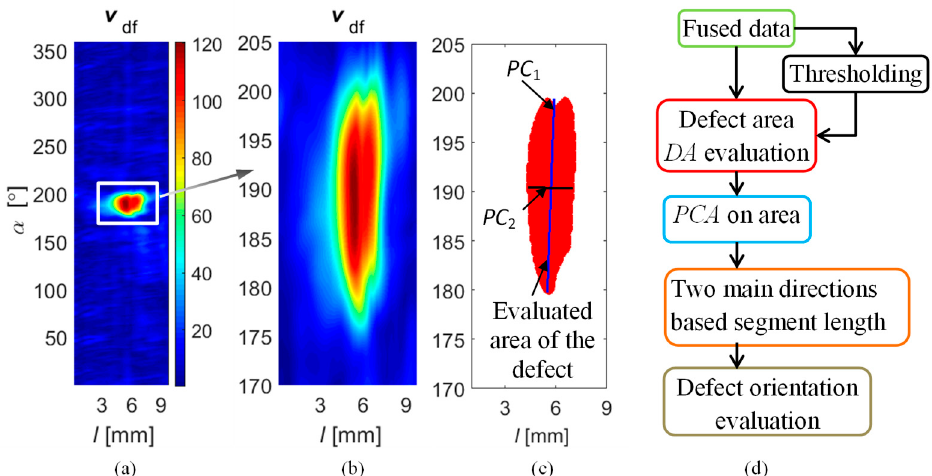
Figure 18. Results of successive stages of final defect identification procedure: fused results ( a ); zoomed defect area ( b ); indication of evaluated defect area together with the two main axes of area variation ( c ); block diagram of the successive steps of the defect orientation procedure ( d ).